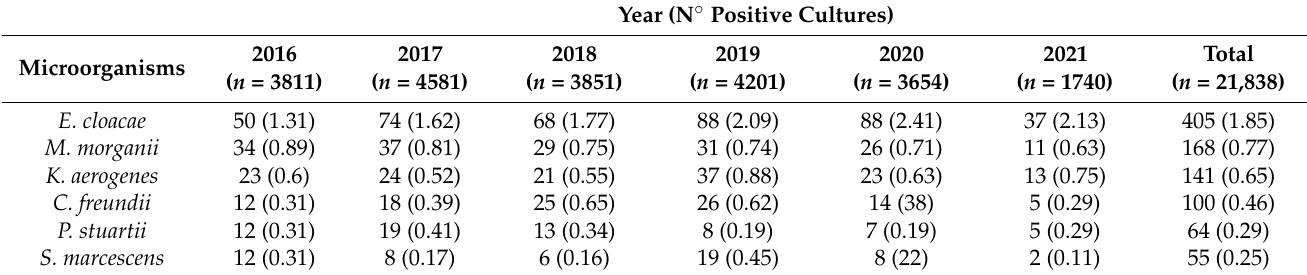
Table 1. Number of clinical isolates and percentage of those positive for tested microorganisms each year.